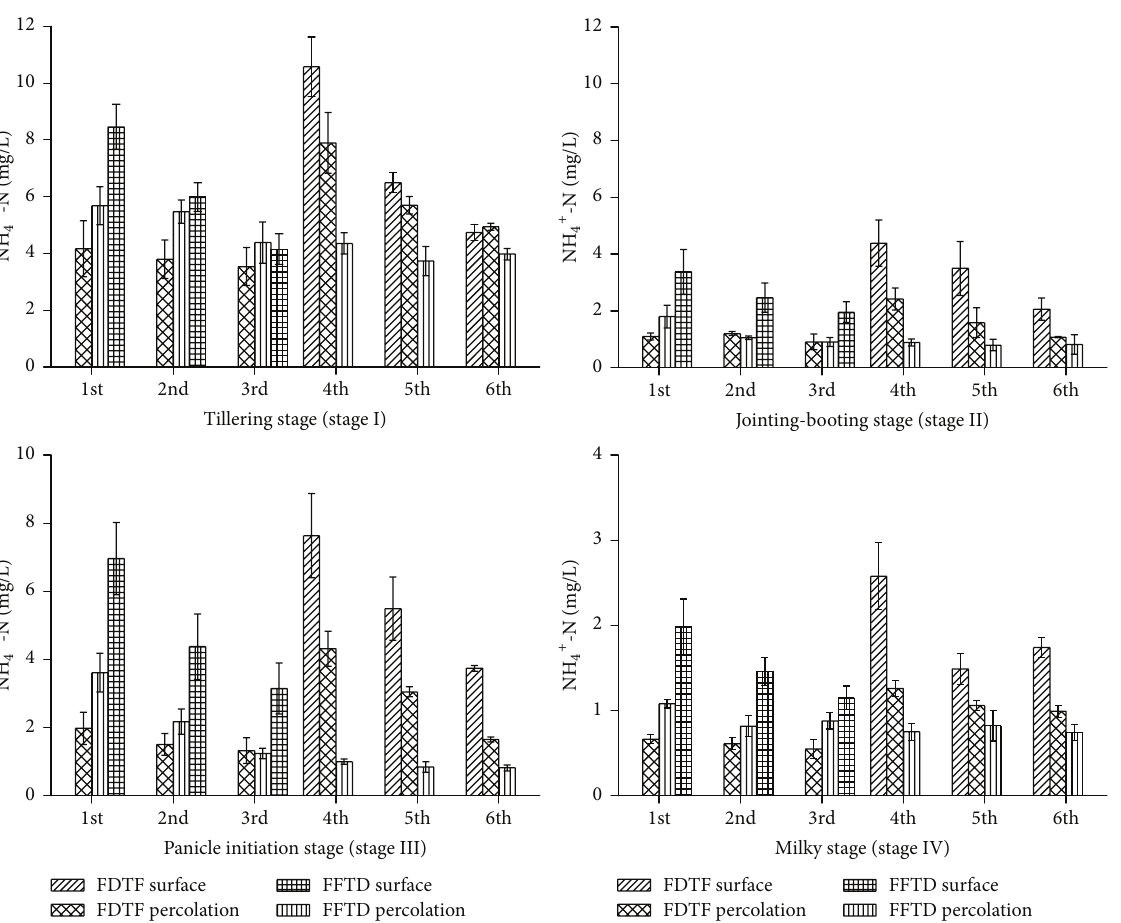
Figure 1: Change of NH 4+ -N concentration at each stage. FDTF indicates first drought and then flooding; FFTD indicates first flooding and then drought. 1st, 2nd, and 3rd indicate the concentration on the first, third, and fifth day of flooding for the FFTD treatments and at the water level of 0mm, − 250 mm, and − 500 mm for the FDTF treatments. 4th, 5th, and 6th indicate the concentration on the first, third, and fifth day of flooding for the FDTF treatments and at the water level of 0mm, − 250 mm, and − 500mm for the FFTD treatments. Vertical bars represent standard error of the mean.